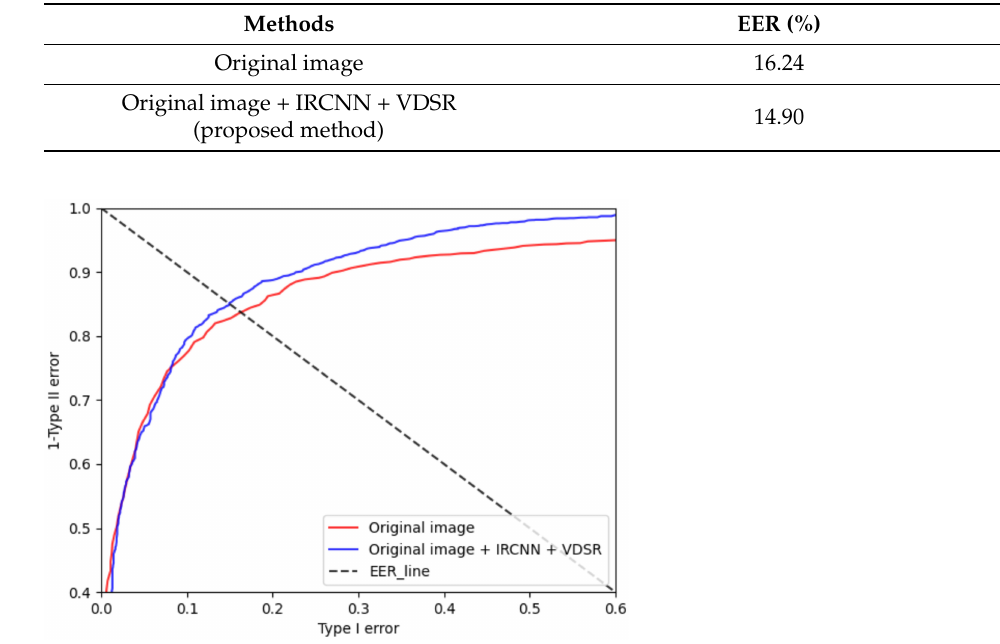
Table 13. Comparisons of gender recognition accuracies using the reconstructed visible-light images.